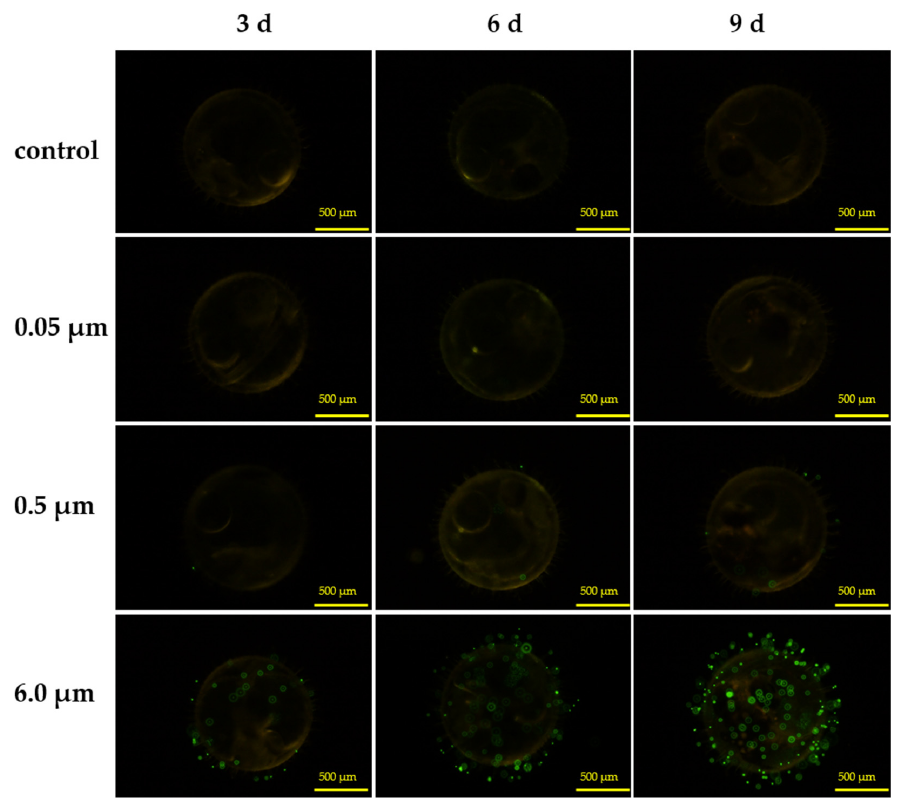
Figure A5. Accumulation of PS-MPs of different sizes on the chorion of O. melastigma embryos (n = 9: Scale bar = 500 μ m). Table A1. Primer sequences used for qPCR in this study.